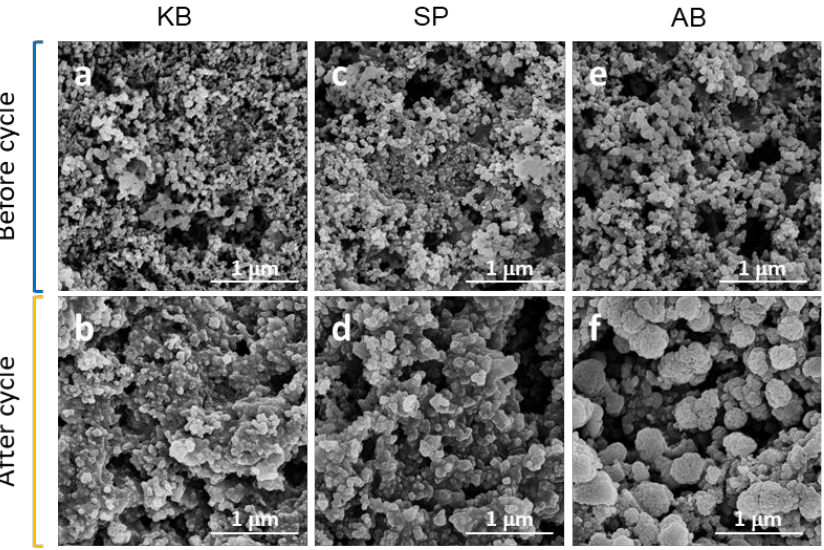
Figure 4. SEM images of SiO 2 electrode with KB ( a , b ), SP ( c , d ), and AB ( e , f ) before and after 200